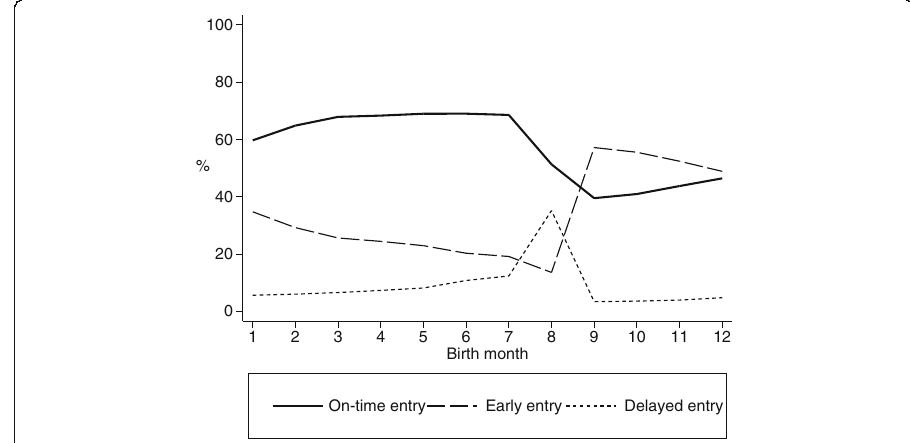
Fig. 5 Percent of on-time entry, early entry, and delayed entry by birth